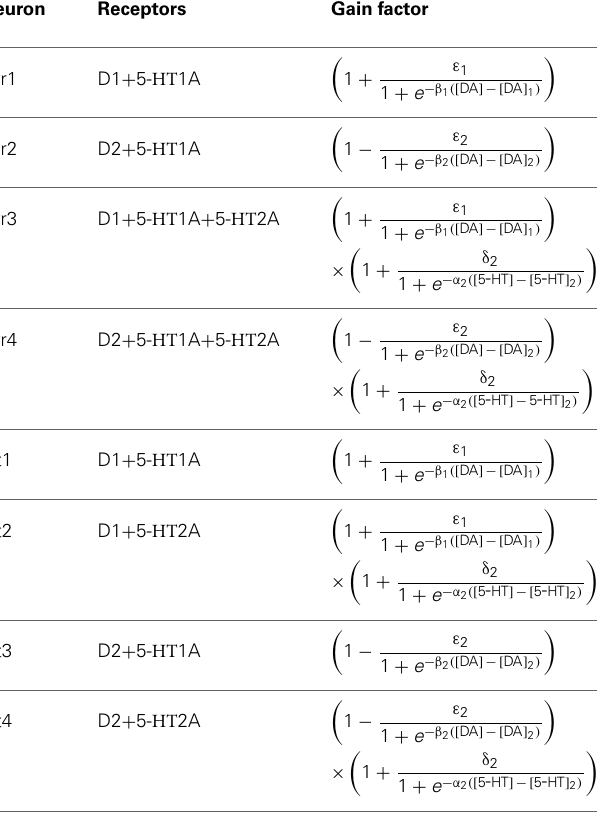
Table 2 | Gain factor for the neuronal subgroups. Neuron Receptors